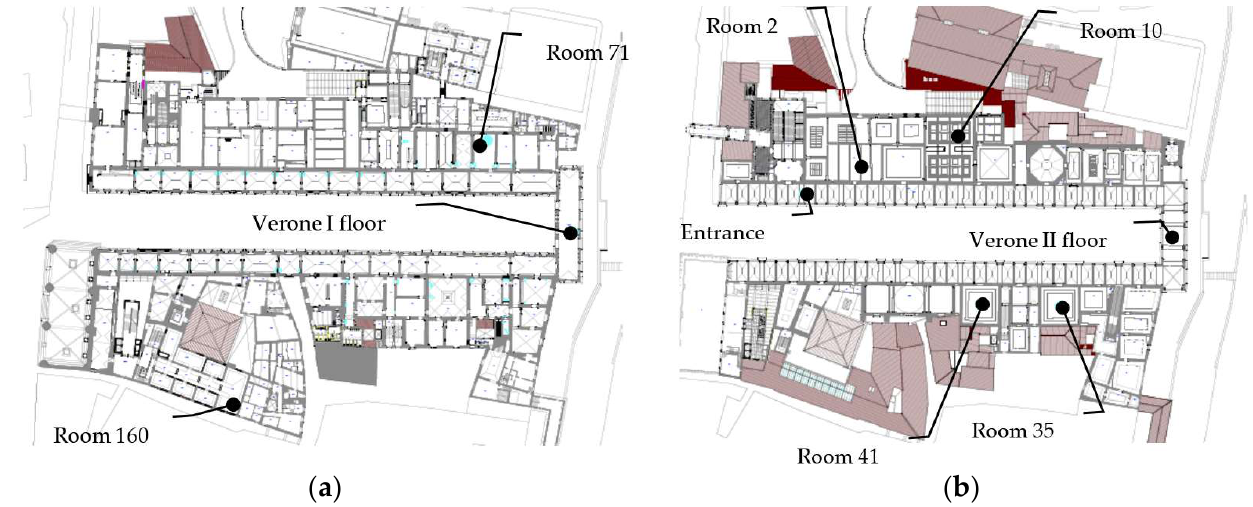
Figure 1. Plan of the first ( a ) and the second ( b ) floor of the Uffizi Gallery pointing out the analyzed rooms.